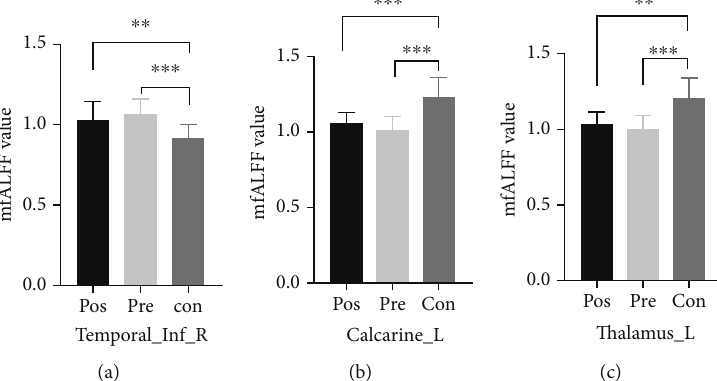
Figure 4: The di ff erence of mfALFF in traditional frequency band between patients before and after treatment and HCs (pos: stroke patients after treatment; pre: stroke patients before treatment; con: healthy controls; ∗∗ indicated P < 0 : 01 ; ∗∗∗ indicated P < 0 : 001